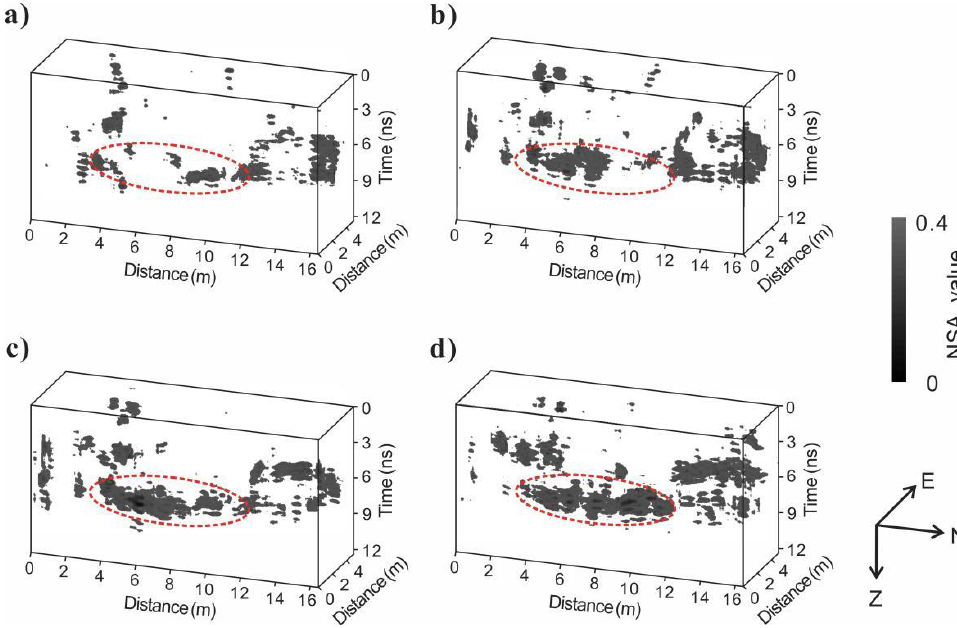
Figure 9. NSA value of the TLFC 3D GPR data: ( a ) 22 Jul. to 30 Jul.; ( b ) 22 Jul. to 8 Aug.; ( c ) 22 Jul. to 22 Aug.; ( d ) 22 Jul. to 30 Aug. The red dotted circle area faces the gate of the construction site, which belongs to the key rolling area of the engineering vehicles.